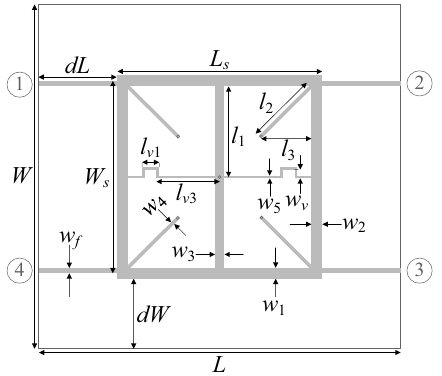
Figure 11. Geometry of dual-band branch-line coupler 65 .